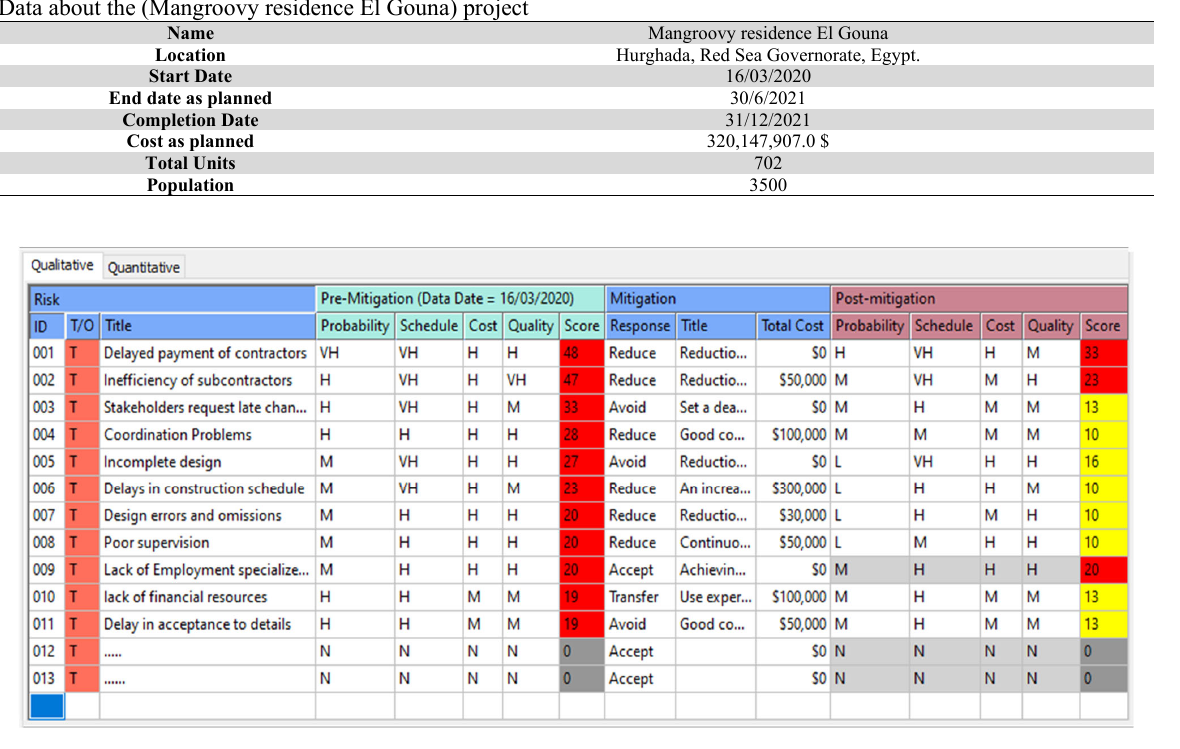
Fig. 6. proposed model for the project's risk